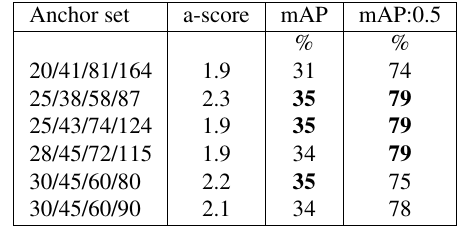
Table 5. Anchor search experiments